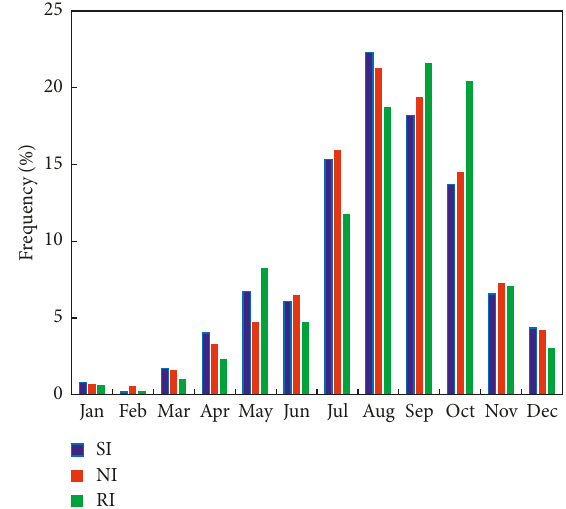
Figure 5: The frequency distribution of the initial month of the development for the three intensification categories (RI, NI, and SI) in the Northwest Pacific